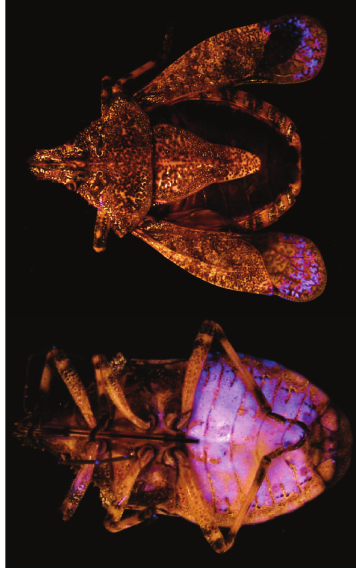
Figure 2: Blue fluorescence in UV light on dorsum (top) and ven- trum (bottom) of Brochymena sulcata (Hemiptera: Pentatomidae). Color intensity digitally